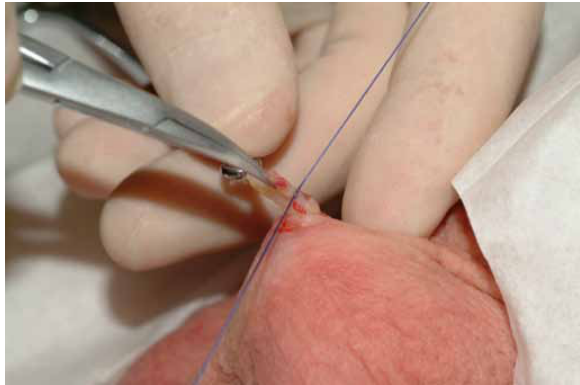
Figure 9 - Ligating the fascia over the prostatic stump